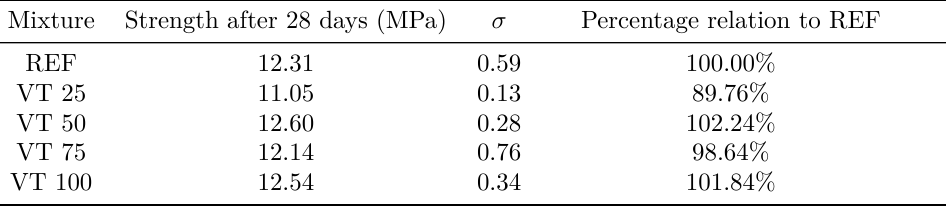
Table 5. Flexural strength (blocks 40